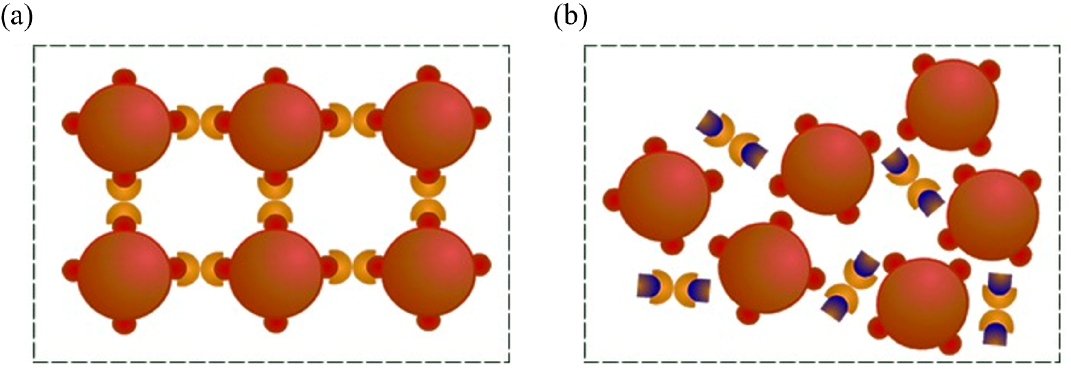
Figure 2. Representation of the behavior of the lectin in the hemagglutination inhibition. ( a ). Before interactions and ( b ). After interactions. Here, round ball shape means erythrocytes, moon shape means lectins and bullet shape is